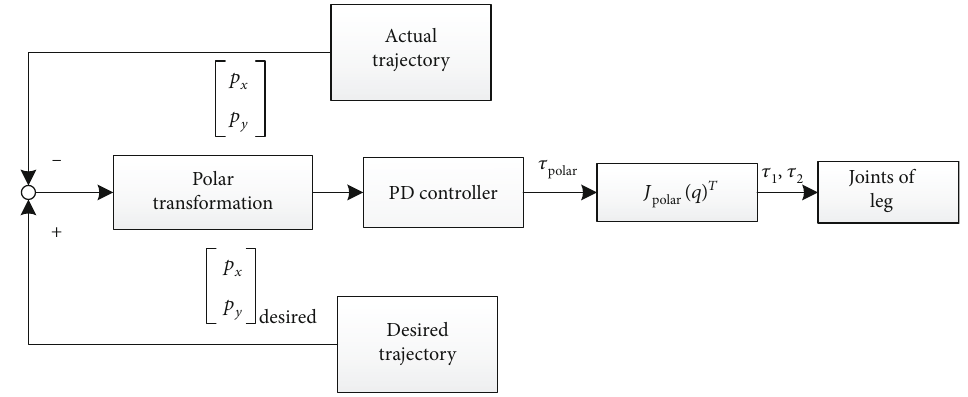
Figure 8: Block diagram for impedance controller.